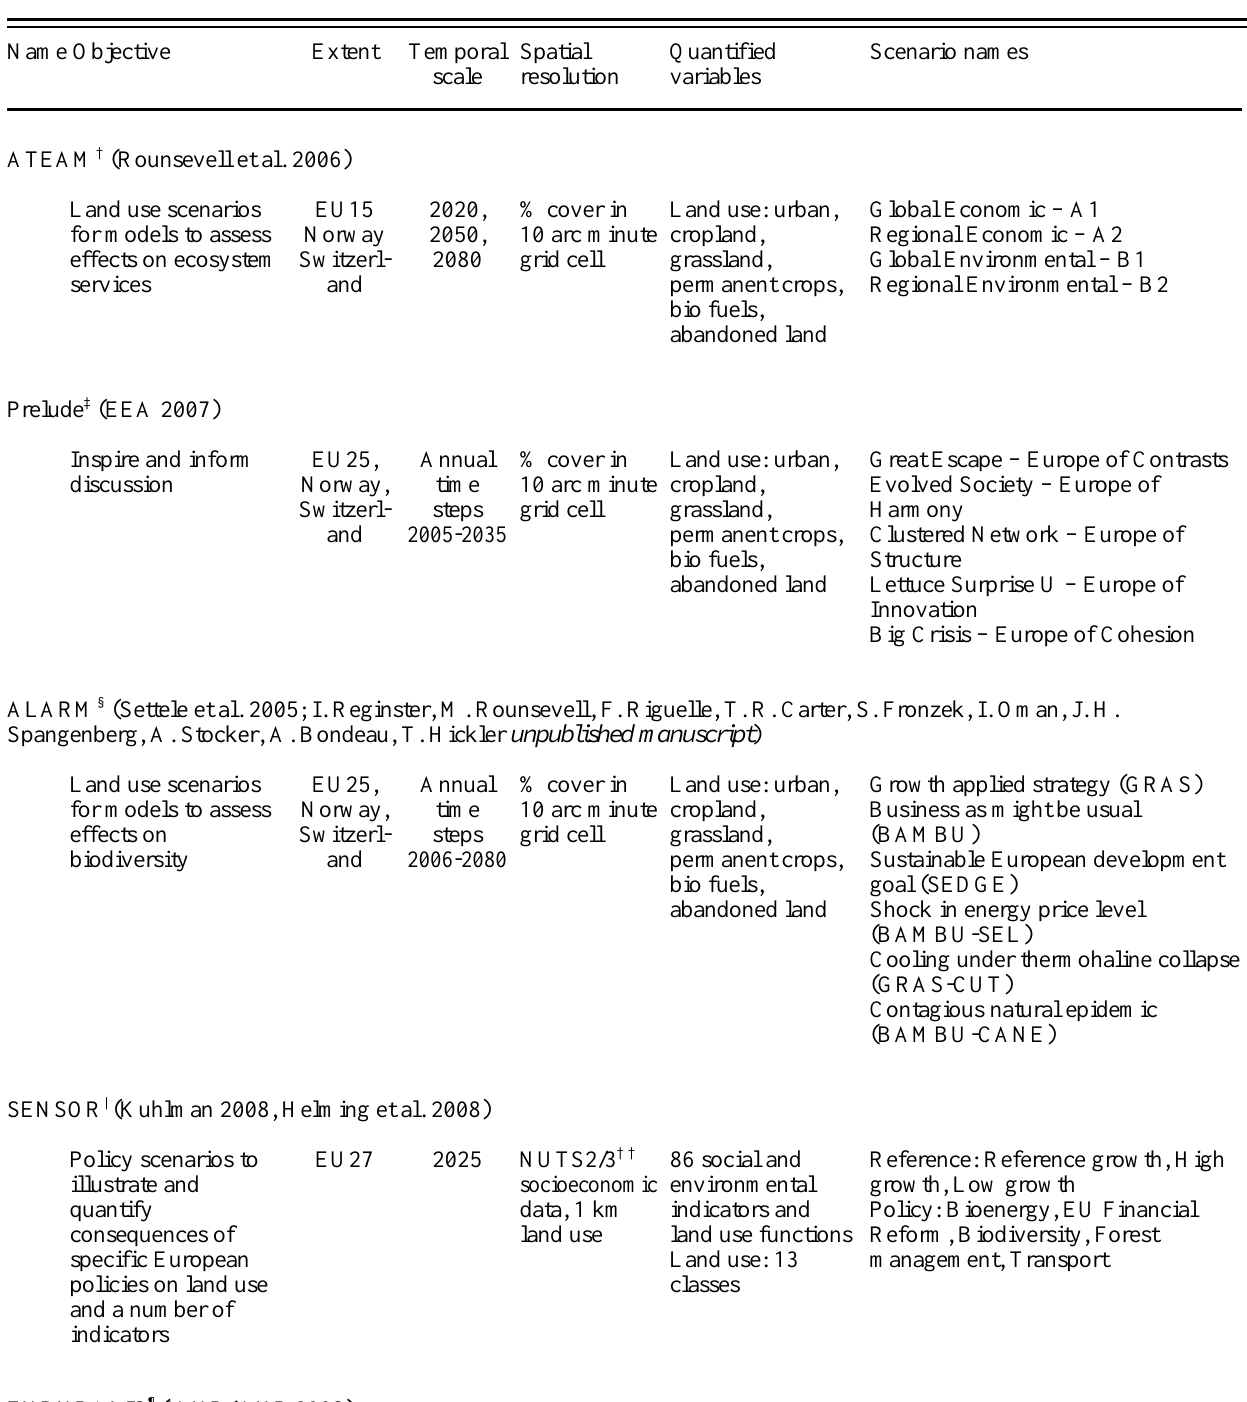
Table 1. Overview of a range of existing scenario studies for the European